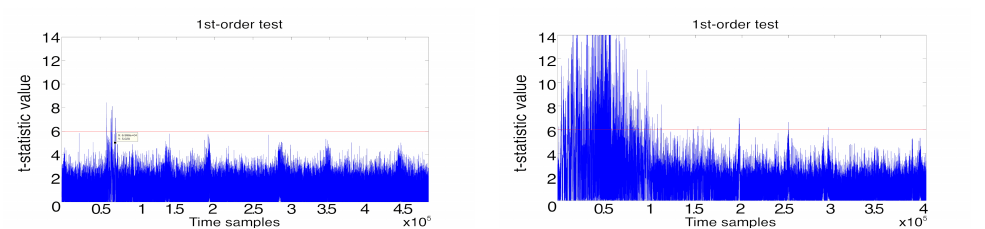
Figure 6: unprotected () random vs fixed scalar